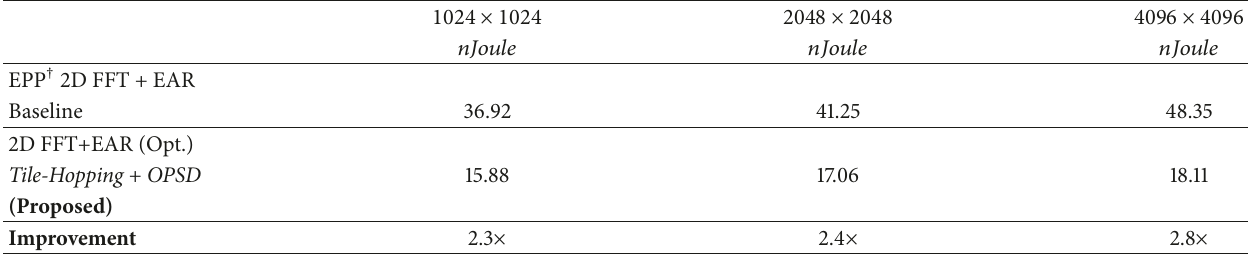
Table 4: 2D FFT + EAR energy consumption baseline vs optimized (OPSD + tile